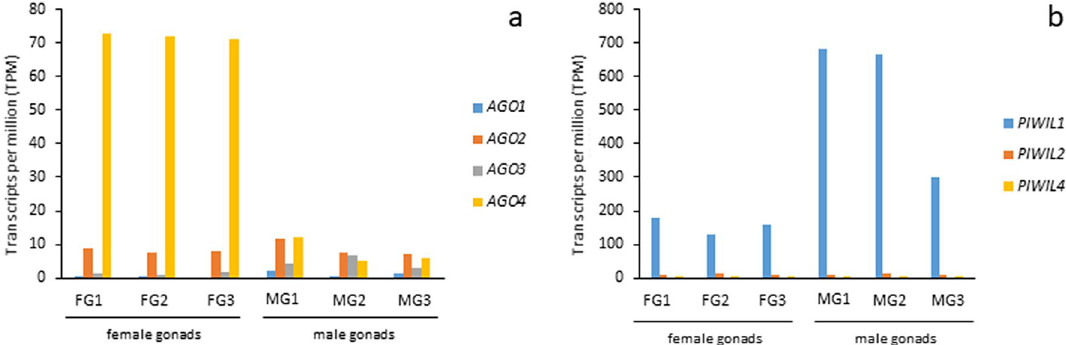
Figure 2. Expression levels of AGO genes. (a) Expression values of Ago genes detected in Cynops orientalis transcriptomes obtained from the female and male gonadal tissues. (b) Expression values of Piwi genes detected in C. orientalis transcriptomes obtained from the female and male gonadal tissues. FG female gonad, MG male gonad.